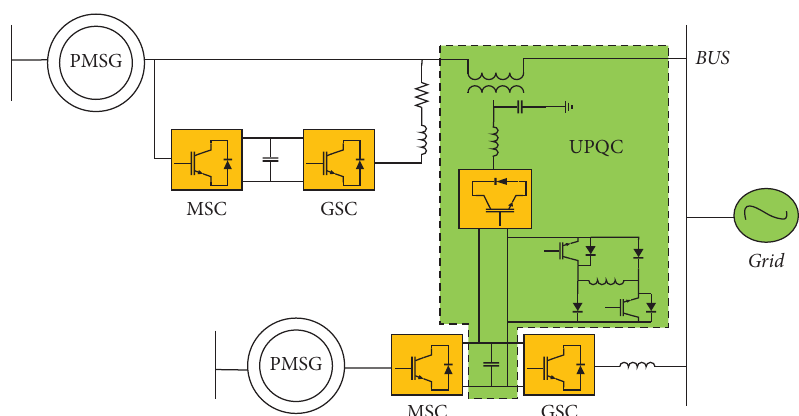
Figure 12: A confguration gathers PMSWG, DFIWG, SMES, and